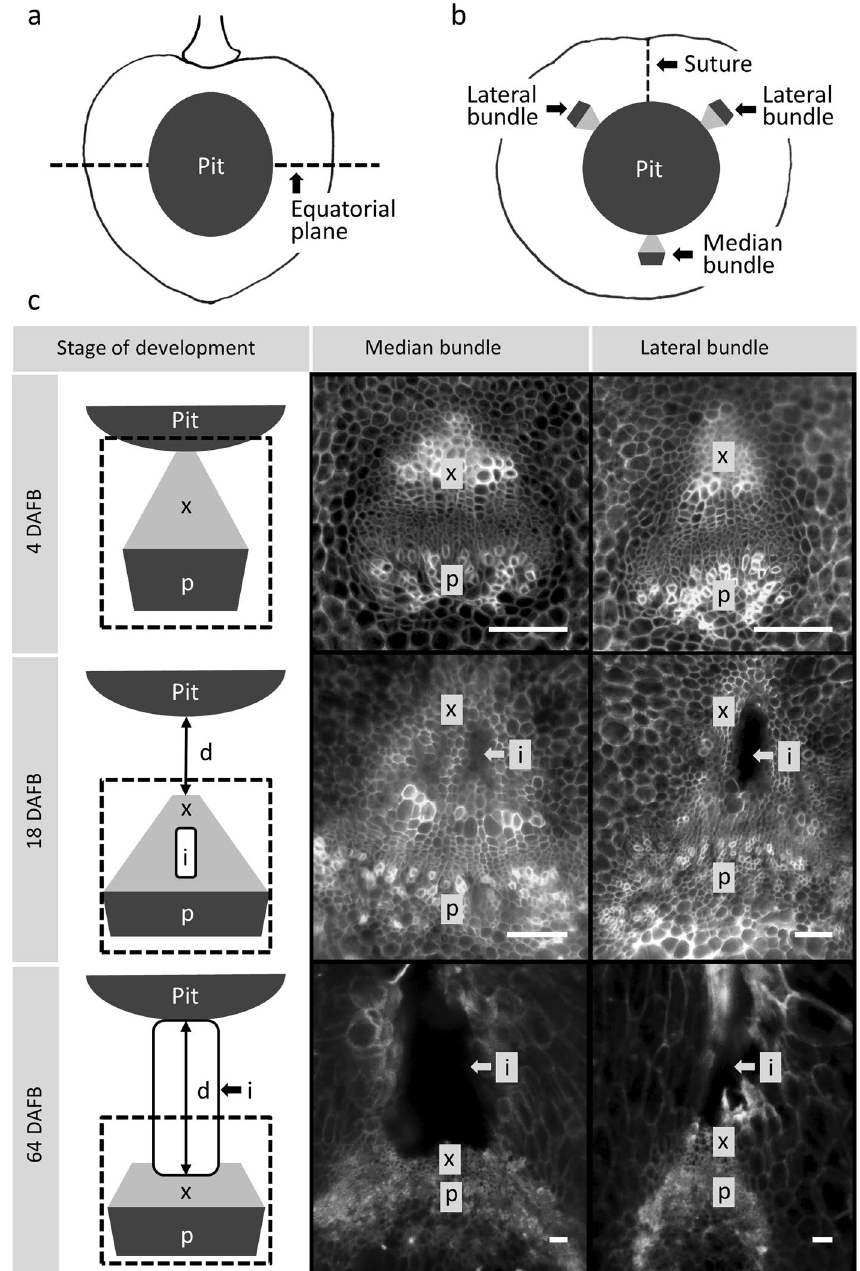
Figure 4. ( a, b ) Diagram of sweet cherry fruit. ( a ) Longitudinal section. ( b ) Cross-section in the equatorial plane indicating positions of the suture, the two lateral bundles and the median bundle. The dashed line in a indicates equatorial plane. ( c ) Sketch (left column) and corresponding micrographs of cross-sections through the median bundle (centre column) and lateral bundle (right column) at an early stage I (4 days after full bloom (DAFB), top row), an intermediate stage (18 DAFB, centre row), and a mature stage III (64 DAFB, bottom row). Scale bar 50 μm, i = intercellular space, p = phloem, x = xylem, d = distance pit – xylem, dashed boxes in diagrams indicate position of the microscope